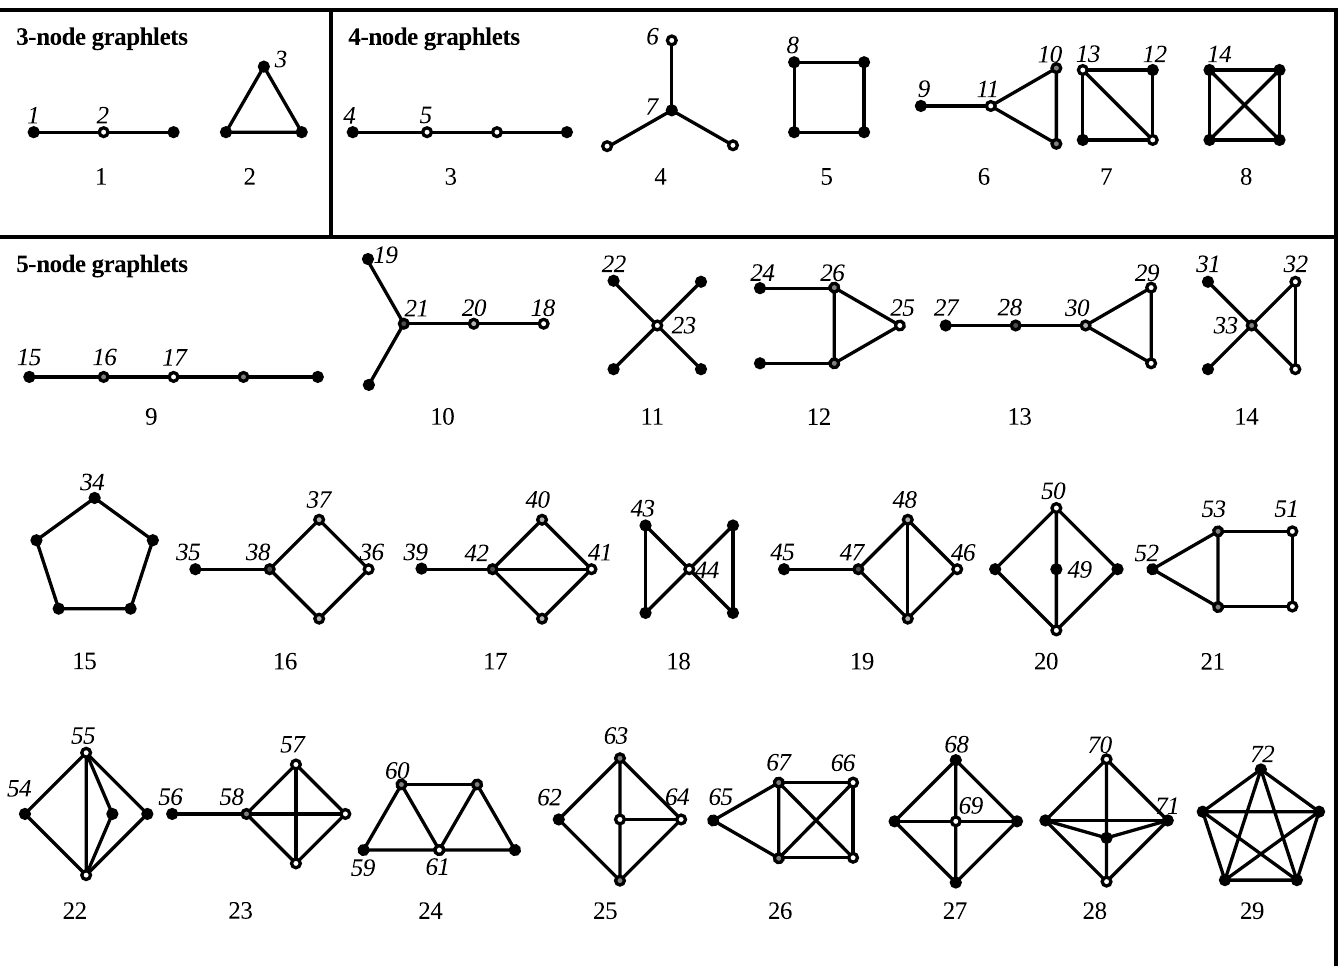
Fig 1. All graphlets up to order 5. The numbers in normal font are Pr ž ulj ’ s graphlet ordering. Within each graphlet, the vertices with equal color are in the same orbit. The numbers in italic font are Pr ž ulj ’ s orbit